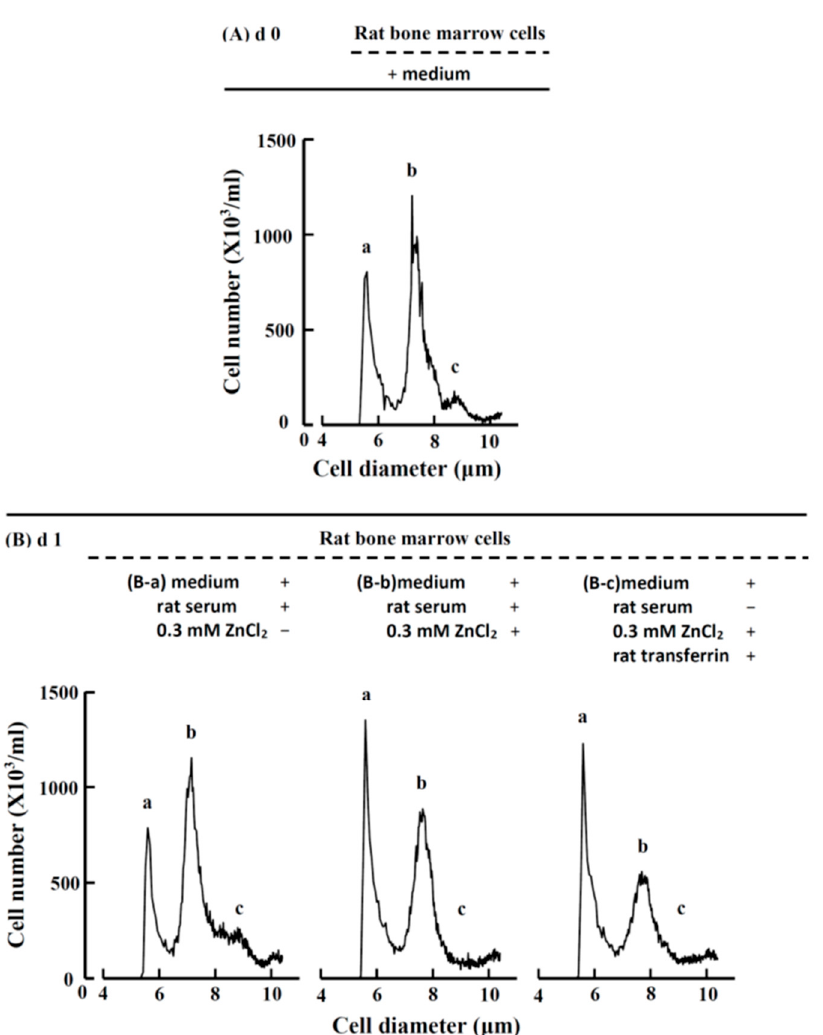
Figure 5. Cell diameter and number before and after zinc or rat transferrin supplementation of the rat bone marrow cell culture. ( A ) At day 0, the rat bone marrow cells (with medium) could be separated into three groups, namely, the ‘a’, ‘b’, and ‘c’ groups, which had peaks at 5.1, 7.4, and 8.5 µ m, respectively; ( B-a ) After the cells were suspension-cultured with rat serum but without ZnCl 2 for one day, the cell diameter and number did not change significantly; ( B-b ) When ZnCl 2 was supplemented to the cells (with medium and rat serum), which were suspension-cultured for one day, the cell distribution changed greatly. The ‘a’ group cell number increased from 726 ± 42 to 1138 ± 188 × 10 3 /mL ( n = 6) (1.6-fold, p < 0.01); however, the ‘b’ group cell number decreased from 913 ± 73 to 719 ± 94 × 10 3 /mL ( n = 6) (0.8-fold, p < 0.05); ( B-c ) When ZnCl 2 and rat transferrin were supplemented to the cells (with medium but without rat serum) for one day, the changes in cell distribution and cell number were quite similar to those in ( B-b ), i.e., the ‘a’ group cell number increased to 1058 ± 42 × 10 3 /mL ( n = 6) (1.5-fold, p < 0.001) and the ‘b’ group cell number decreased to 563 ± 61 × 10 3 /mL (0.6-fold, p < 0.001) ( n = 6). These figures are representative of six different experiments.